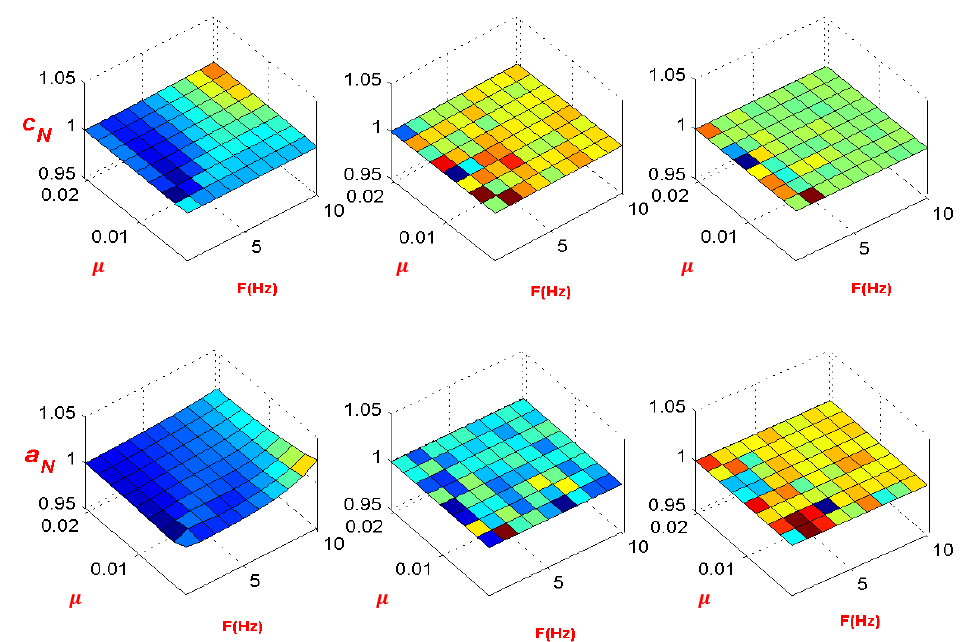
Fig. 5 Three dimensional view (see legend Fig.2) of frequency pattern of normalized phase velocity and normalized attenuation for various wall viscosity ( (cid:2246) = 0.7, 3.2, 5.7, 8.2, 10.7, 13.2, 15.7, 18.2 and 20.7 Pa.s ),